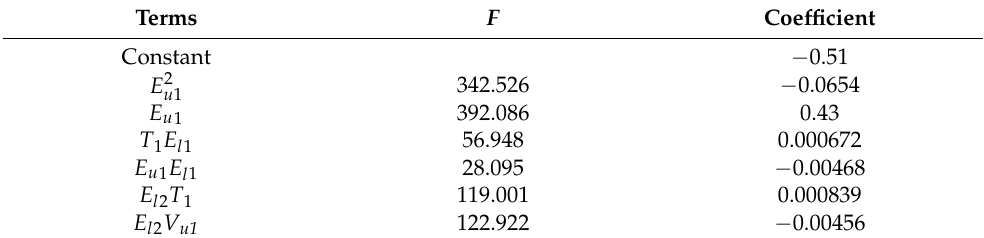
Table 1. Significance of the terms of Equation (5). (Adapted from Table S3.14 in [27], Supplementary Material (“S3.docx” file)).